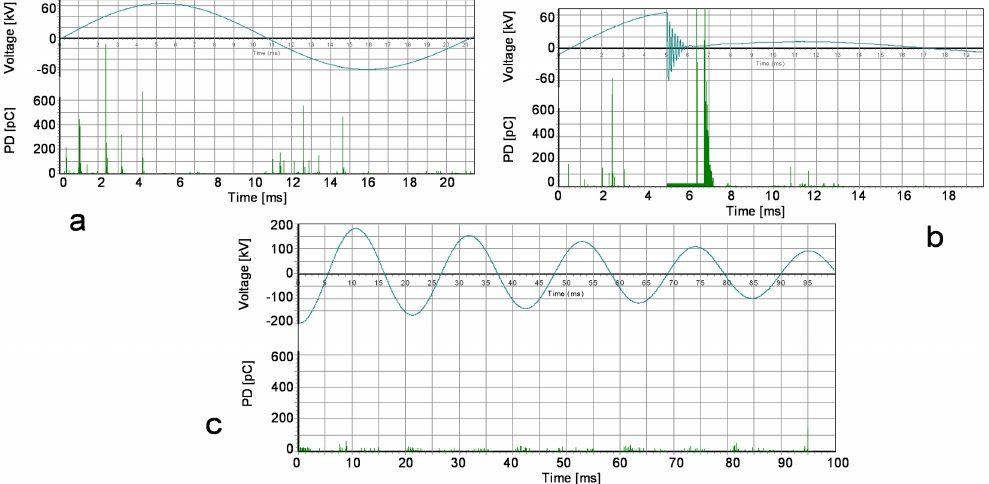
Figure 10. Damped AC voltages and PD patterns as observed during withstand testing of a 220 kV XLPE cable underground circuit (13.3 km): ( a ) example of PD pattern at 0.2 Uo of phase L1, ( b ) example of PD pattern at breakdown voltage of 0.4 Uo of phase L1, ( c ) PD pattern at 1.3 Uo of phases L2 and L3.